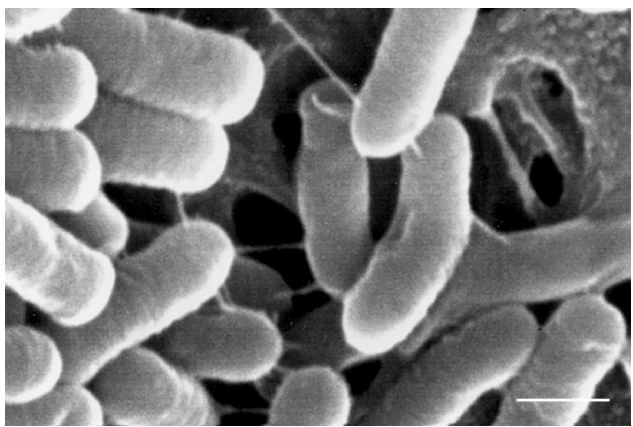
Figure 1. SEM image of exopolysaccharide (EPS)-production by L. plantarum B51. Bar = 0.7 μm.